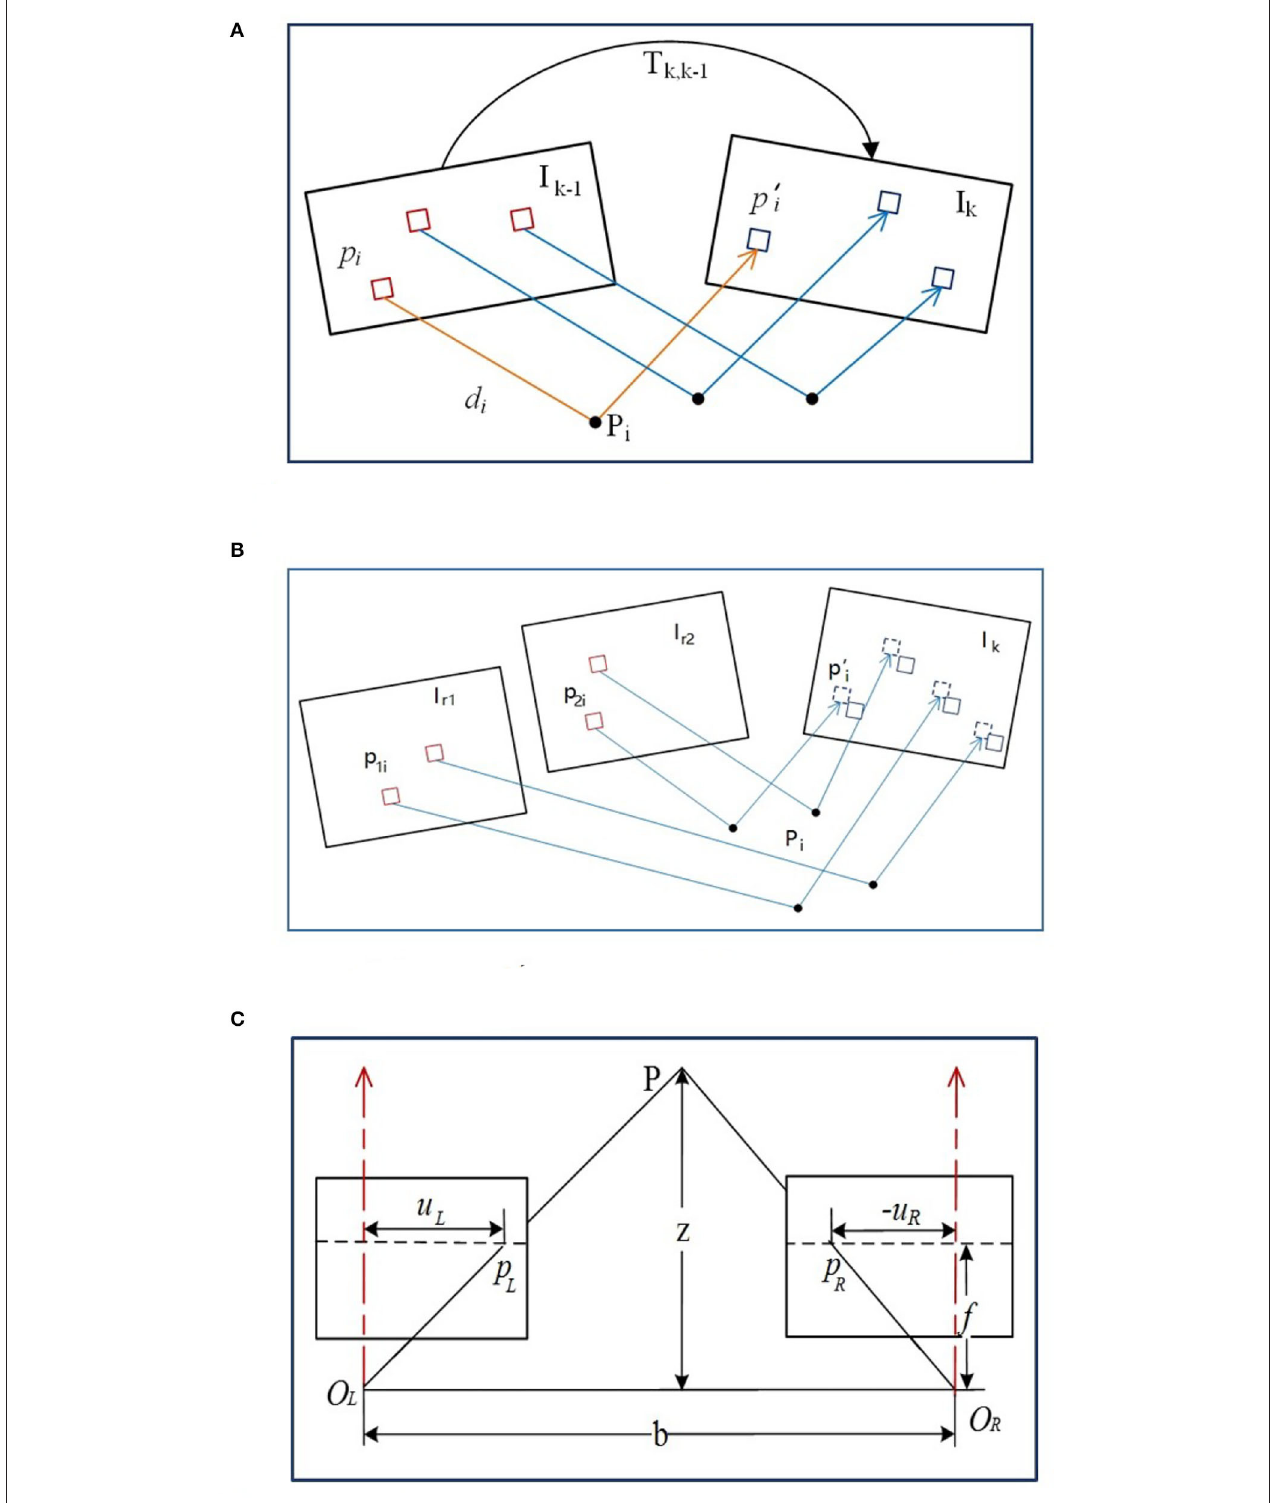
FIGURE 3 | The illustration of image measurement. (A) The direct method based pose estimation. (B) The alignment of feature pixels. (C) Triangulation measurement with stereo camera.